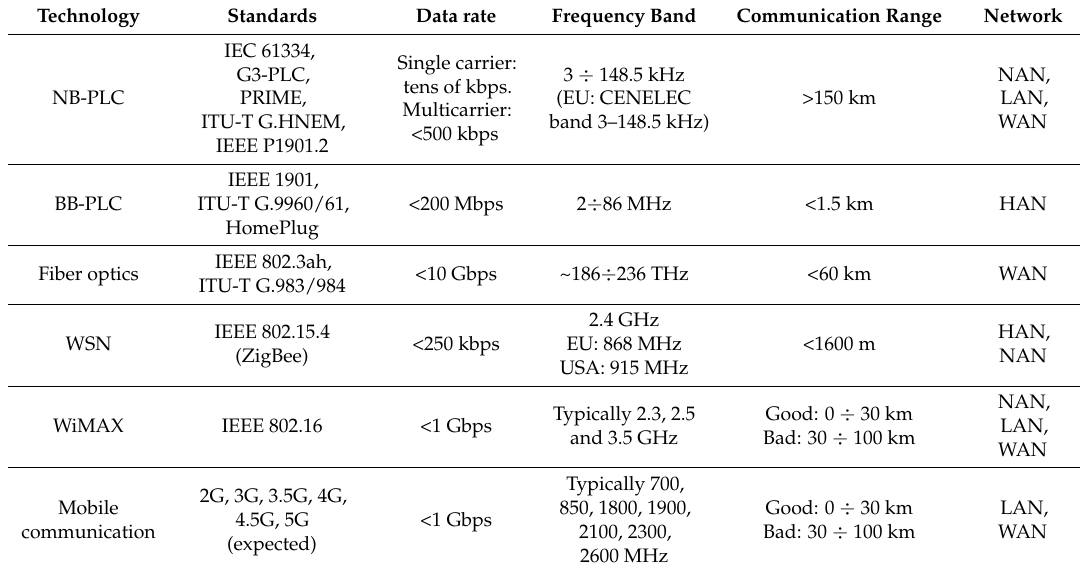
Table 5. Characteristics of main communication technologies used in